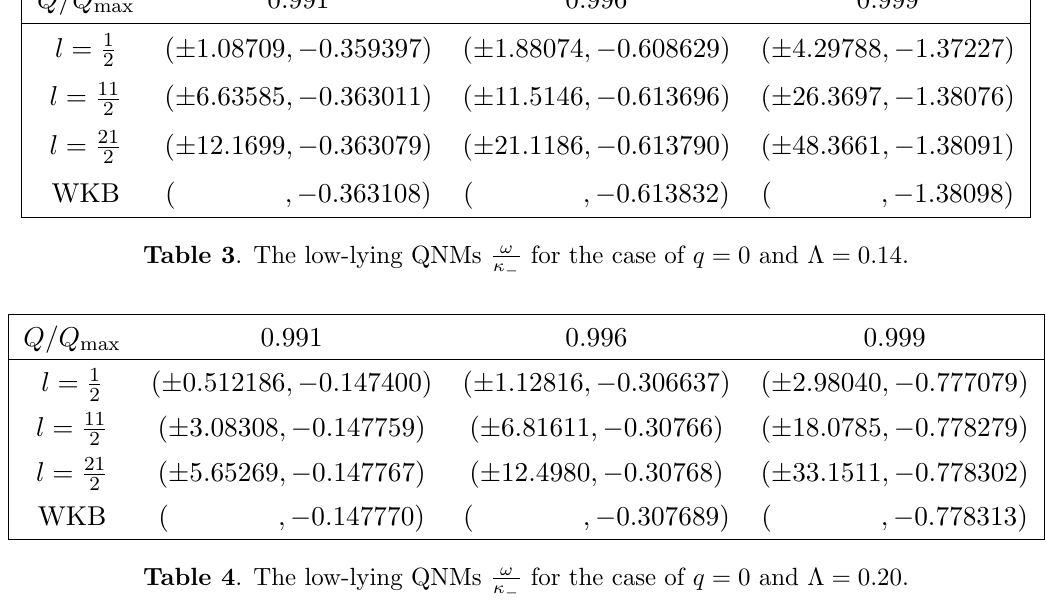
for the case of q = 0 and (cid:3) = 0 : (cid:20) (cid:0)